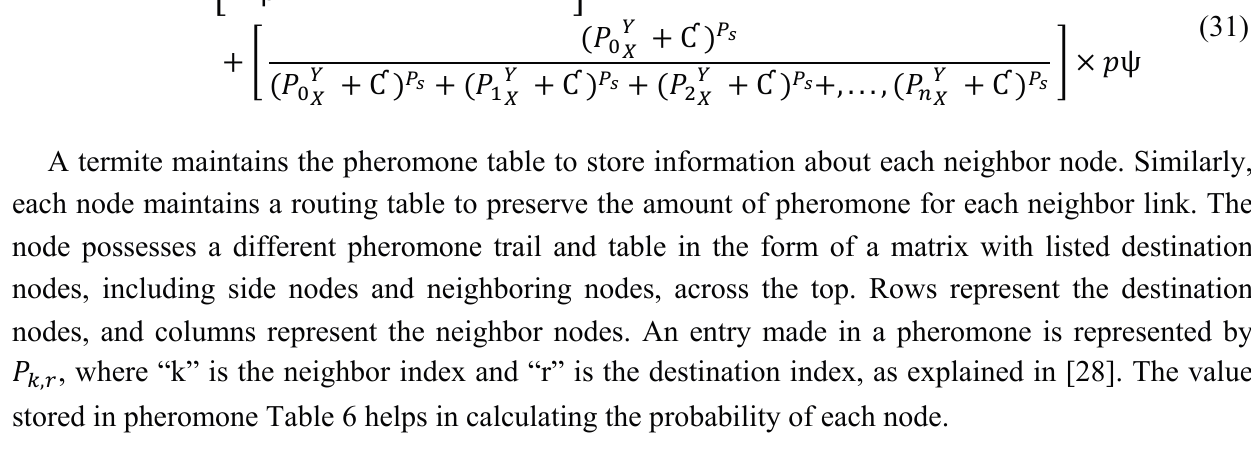
Table 6. Pheromone routing table for node